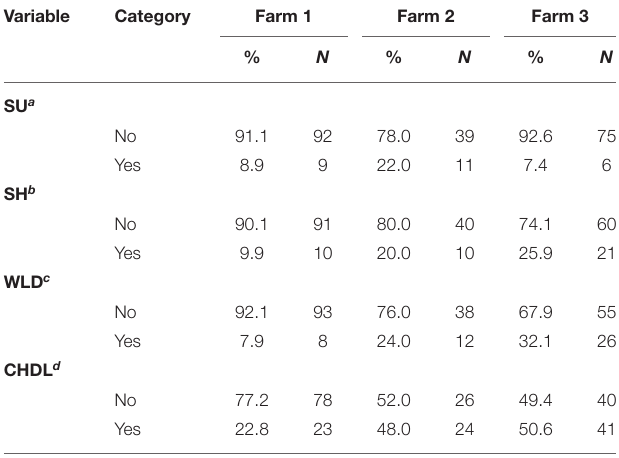
TABLE 4 | Distribution of claw horn disruptive lesions collected at 60 days in milk across the three farms.